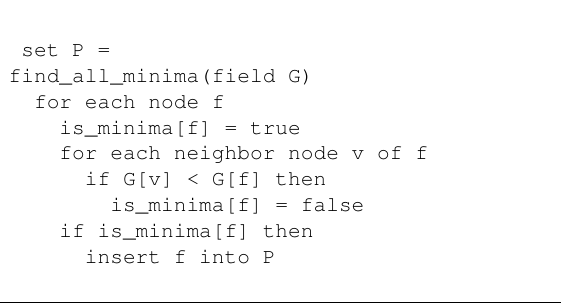
Algorithm 3 Given a field G defined on an unstructured grid and a set of candidate points P , remove candidate minima